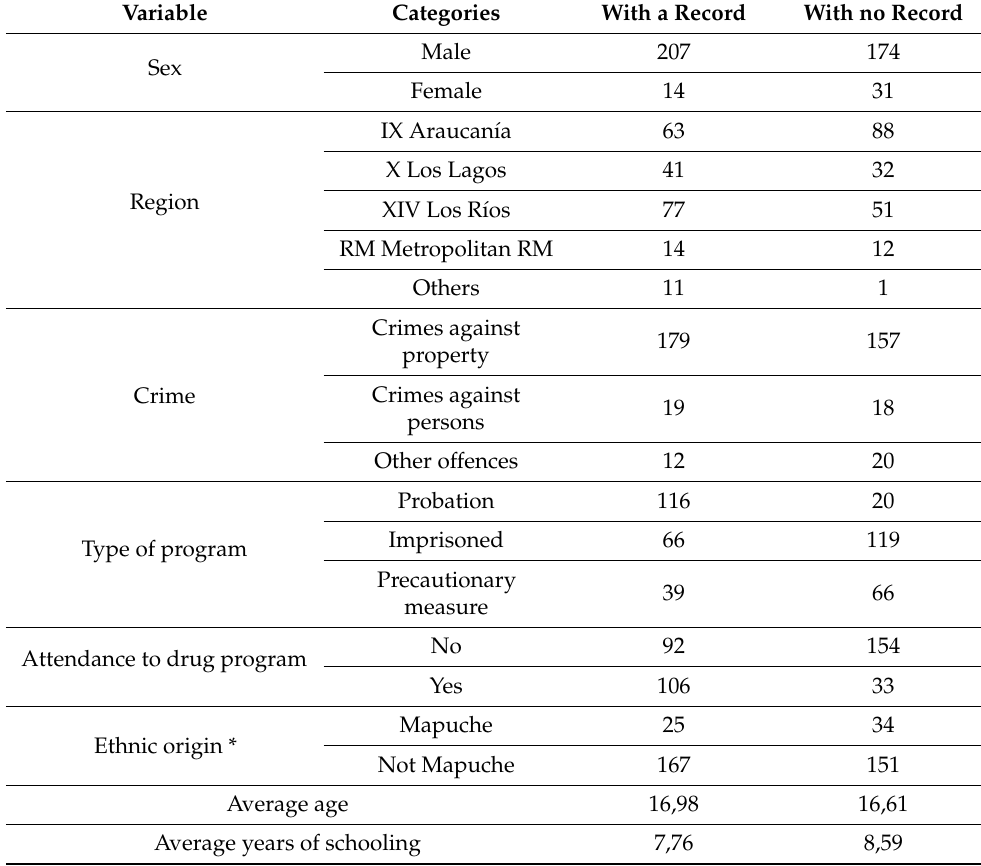
Table 1. Descriptive statistics for the analysis